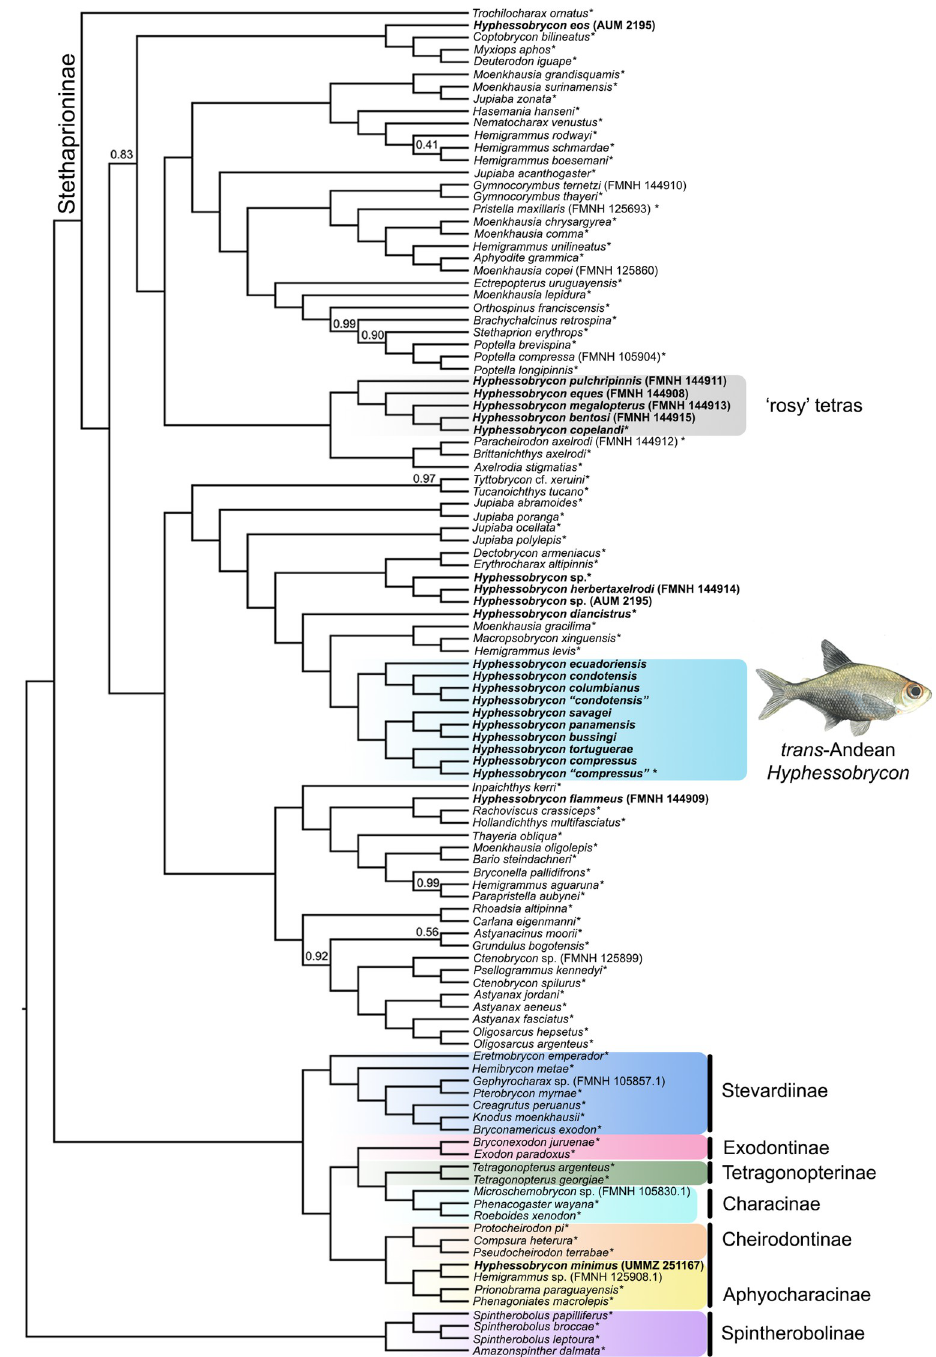
Fig 2. Species tree of the family Characidae inferred with ASTRAL-III based on our 75% complete data matrix (1682 gene trees). All nodes supported by local posterior probabilities (LPP) = 1 unless indicated in the tree. Species of Hyphessobrycon are in bold. Asterisks indicate samples from Melo et al. [9]. Illustration of male Hyphessobrycon compressus by Duangsamorn Boonwun